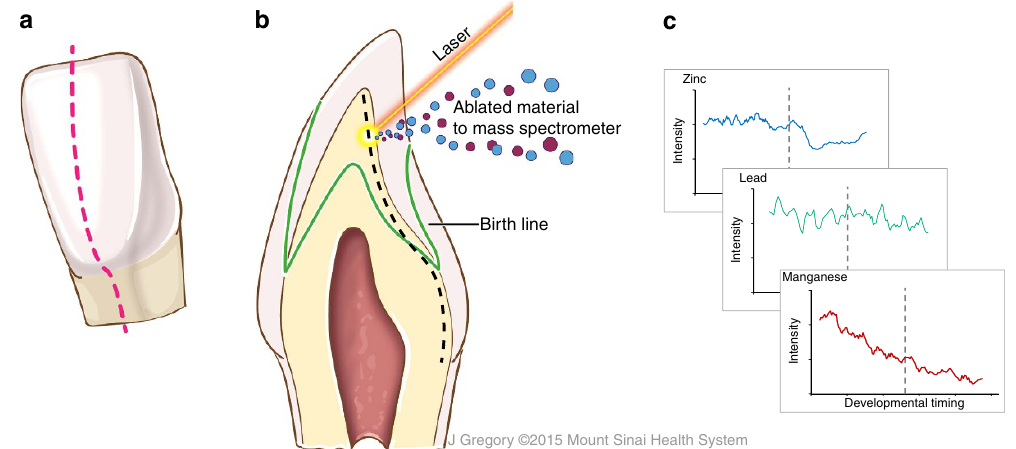
Figure 2 | Overview of tooth-matrix biomarkers applied in this study. ( a ) Plane in which teeth were sectioned. ( b ) Laser ablation-inductively coupled plasma mass spectrometry analysis. The surface of dentine was ablated using a laser and the ejected material transferred to a mass spectrometer. Neonatal line and other histological features are used to select sampling locations adjacent to the dentine-enamel interface extending from the dentine horn to the tooth cervix (dashed black line). ( c ) Output data where developmental timing is assigned to elemental profiles in each sample, reconstructing the history of elemental uptake over the prenatal and early childhood periods. The illustrations were created by Jill K Gregory from the Icahn School of Medicine at Mount